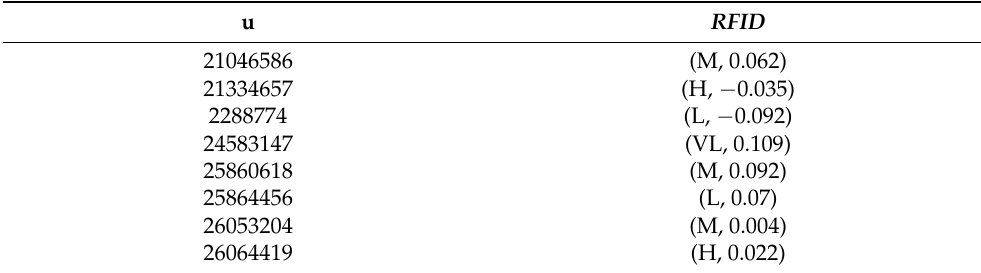
Table 8. RFID overall score for some